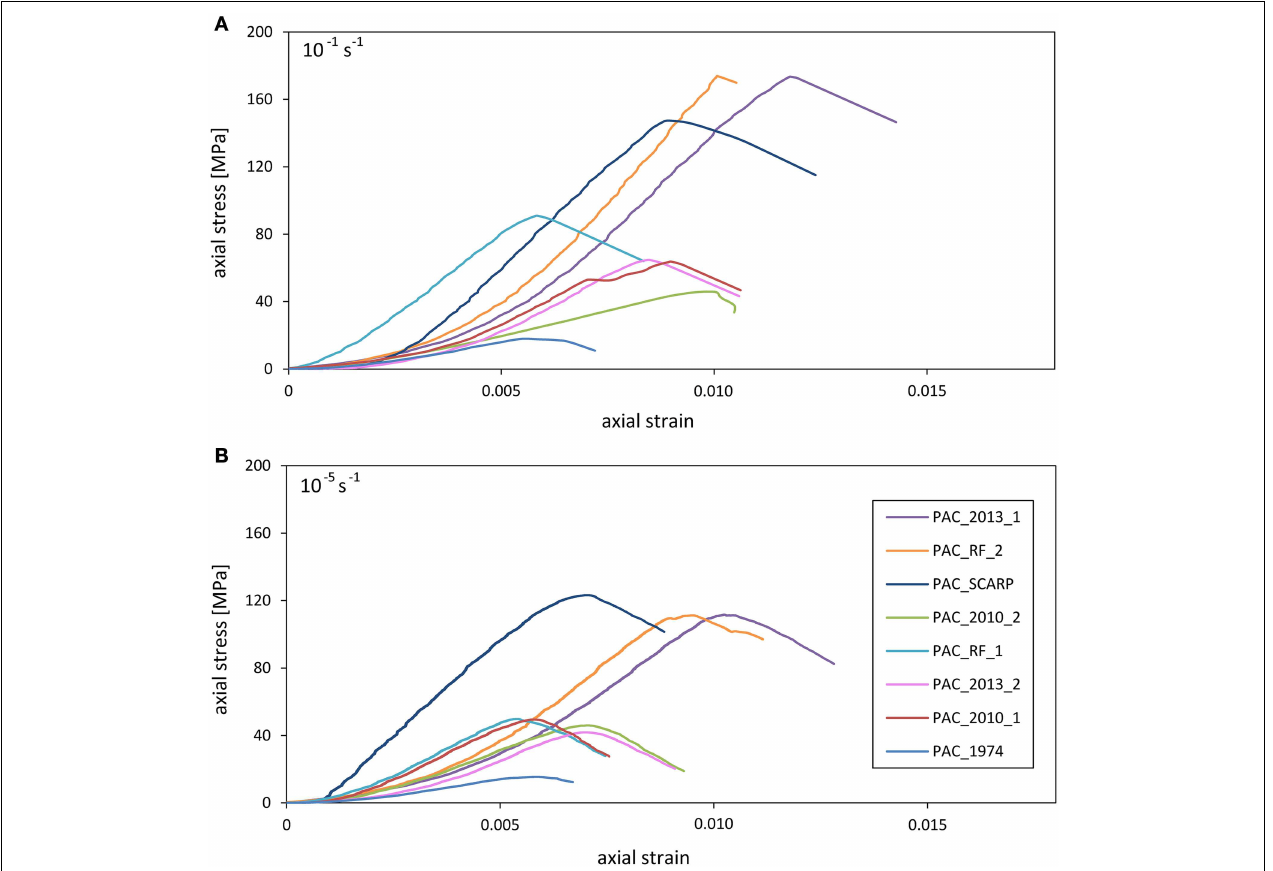
FIGURE 5 | Stress-strain curves for uniaxial compressive strength tests conducted on original cores (i.e., without thermal stressing) at room temperature and strain rates of (A) 10 − 1 s − 1 , and (B) 10 − 5 s − 1 . (A) Compression at this high constant strain rate, results in an initial compaction of the rock and closure of cracks (leading to an initially small stress build up despite a relatively large strain); beyond this point stress increases linearly until values approaching the peak stress, where the onset of strain hardening due